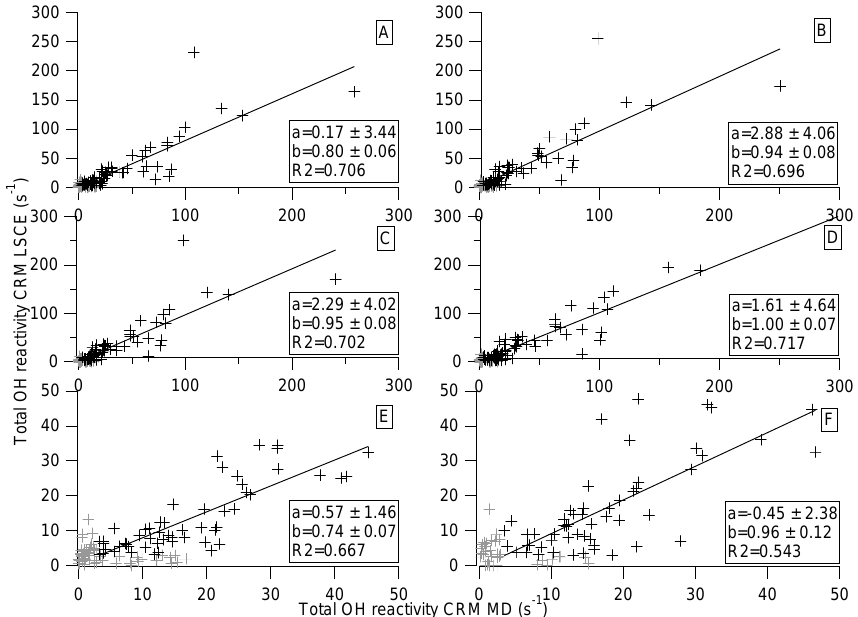
Figure 7. Linear least squares fits of total OH reactivity measured by CRM-LSCE vs. Total OH reactivity measured by CRM-MD. Panels from top left to bottom right show: correlation among raw results (a) ; correlation among data corrected for humidity (b) ; correlation among data corrected for humidity and deviation from pseudo first order kinetics (c) ; correlation among data corrected for humidity; kinetics regime and dilution inside the reactor (d) ; correlation among raw values in the range 0–50s − 1 (e) ; correlation among final values in the range 0– 50s − 1 . (f) . Coefficient values are extracted from the equation: OH reactivity CRM-LSCE = b (OH reactivity CRM-MD) + a and report 1 σ standard deviation. The regressions are applied to the values above the instrumental LOD